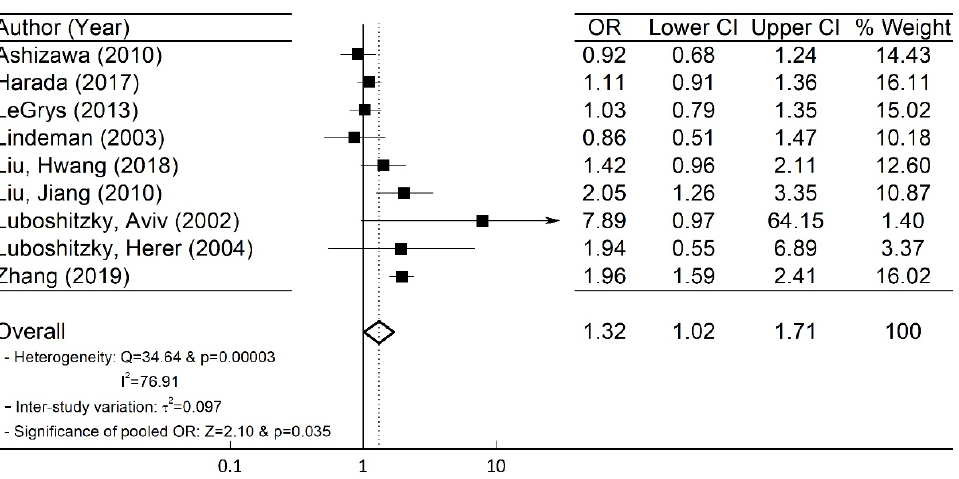
Figure 2. Forest plot of all included studies ( n = 9) showing OR for the association between SCH and HTN. OR for each individual study is represented by a solid square ( ), while its CI is denoted by a horizontal line. A diamond ( ) denotes the CI for the pooled OR, and the vertical dashed line passes the pooled OR. Abbreviations: OR, odds ratio; CI, confidence interval; SCH, subclinical hypothyroidism; HTN,